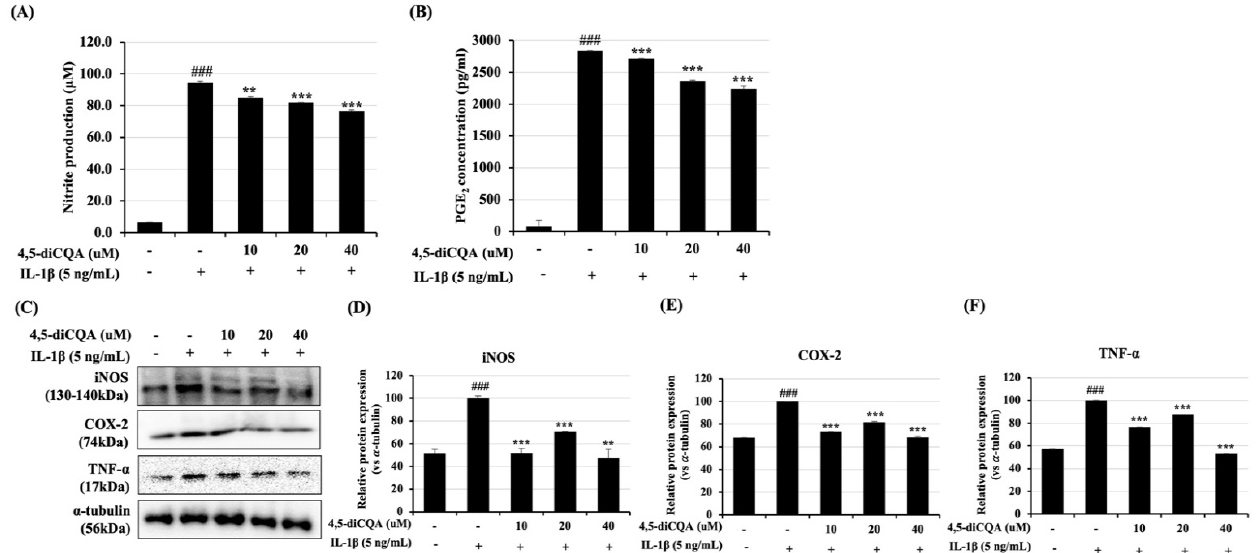
Figure 2. Inhibitory effects of 4,5 − diCQA on IL ‐ 1 β‐ induced nitrite, PGE 2 , iNOS, COX ‐ 2, and TNF ‐α in rat primary chondrocytes. Cells were pre ‐ treated with 4,5 ‐ diCQA (10, 20, and 40 μ M) for 1 h, followed by IL ‐ 1 β (5 ng/mL) stimulation for 24 h. ( A ) Nitrite production was determined in the cultured medium using a Griess reagent. ( B ) PGE 2 production was determined in the cultured medium using an ELISA kit after 24 h. ( C ) Expression of the iNOS, COX ‐ 2, and TNF ‐α was determined using Western blot analysis. α‐ Tubulin served as an internal control. ( D – F ) Quantitative data of ( C ) were analyzed using the ImageJ bundled with Java 1.8.0_172 software. n = 5 per group. Data are represented as mean ± SD of three independent experiments. ### p < 0.005 vs. control group; ** p < 0.05, and *** p < 0.005 compared with the IL ‐ 1 β‐ treated group.